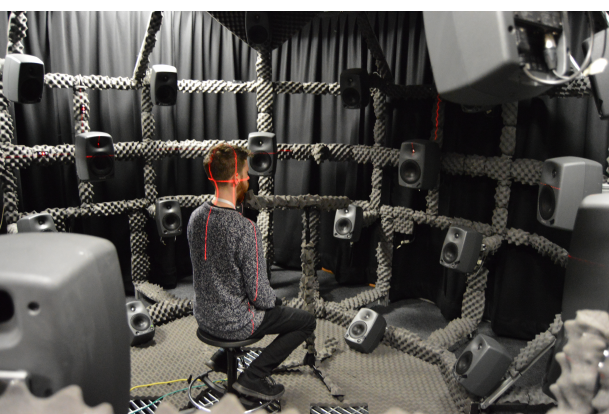
Figure 7. BRIRs of a 50 point Lebedev loudspeaker configuration being measured inside a treated listening